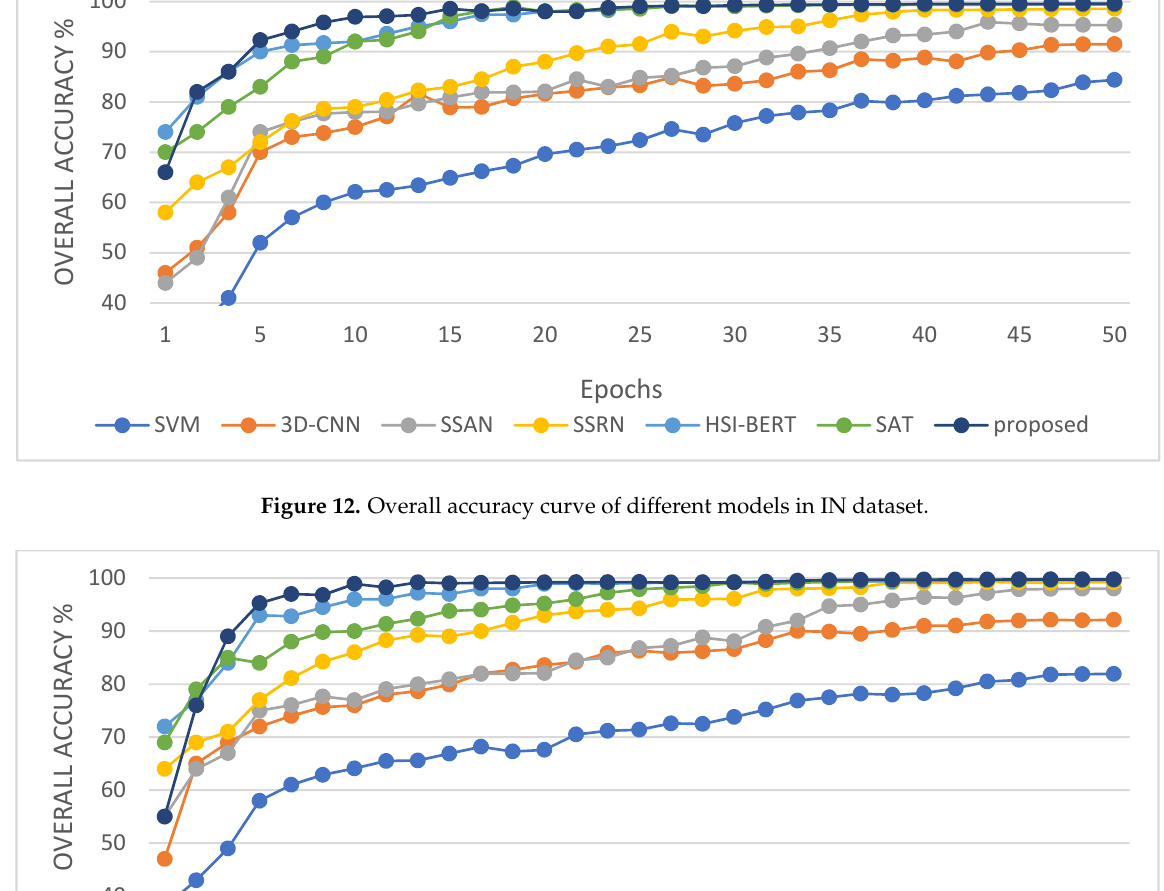
Figure 14. The classification map on the SA dataset for ( a ) SVM, ( b ) 3D-CNN, ( c ) SSAN ( d ) SSRN, ( e ) HSI-BERT, ( f ) SAT, and ( g ) proposed 3DSA-MFN. Red boxes are used to mark non-obvious mis- classifications and noise.